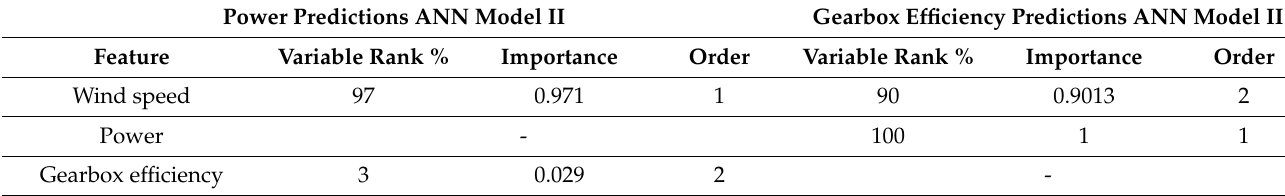
Table 7. Importance analysis for all operating modes in terms of wind